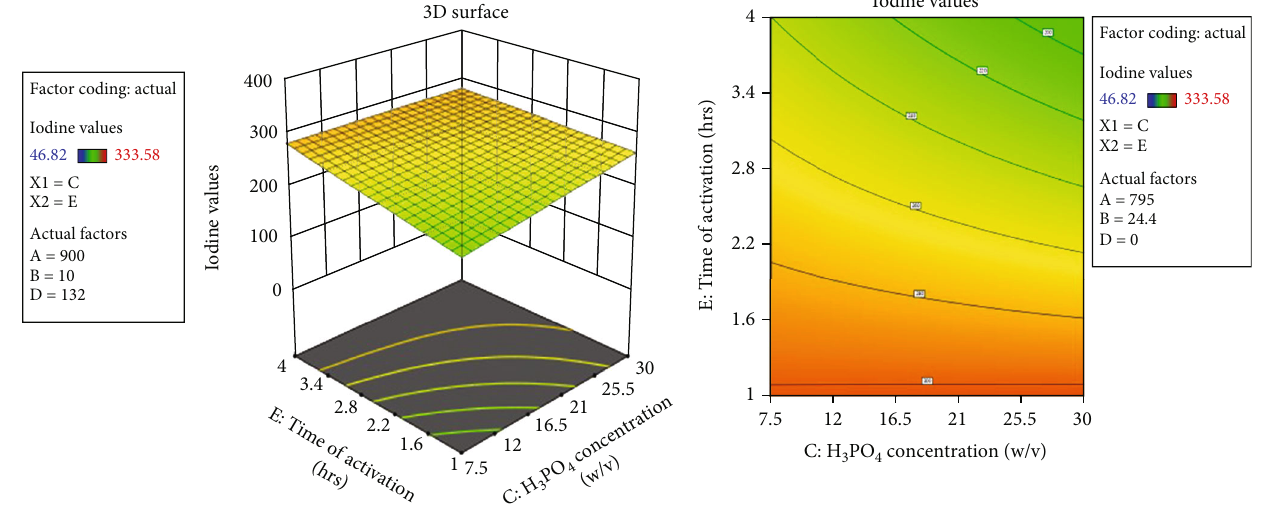
Figure 5: Surface and contour plots of e ff ect of K